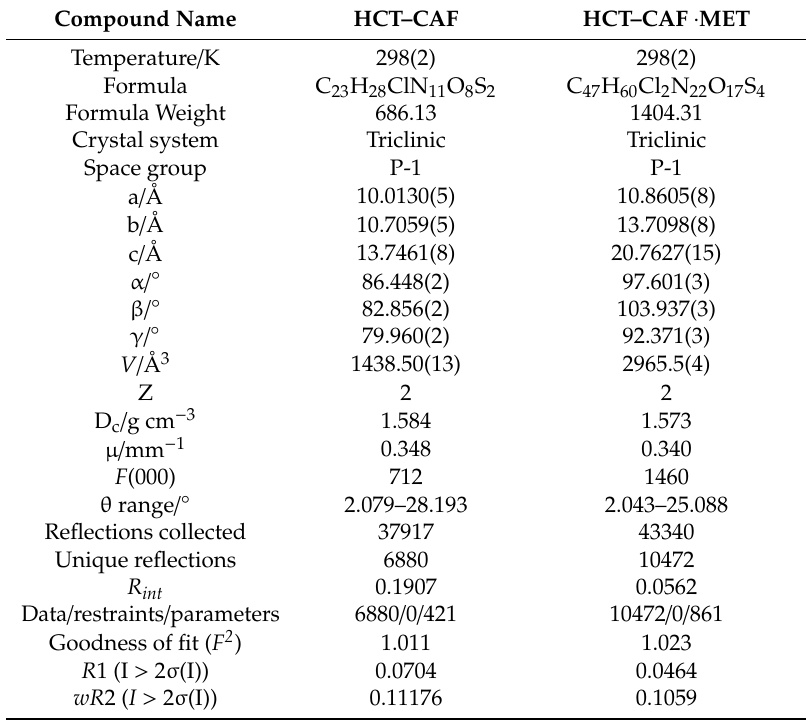
Table 1. Crystallographic data and structure refinement details of compounds 1 and 2